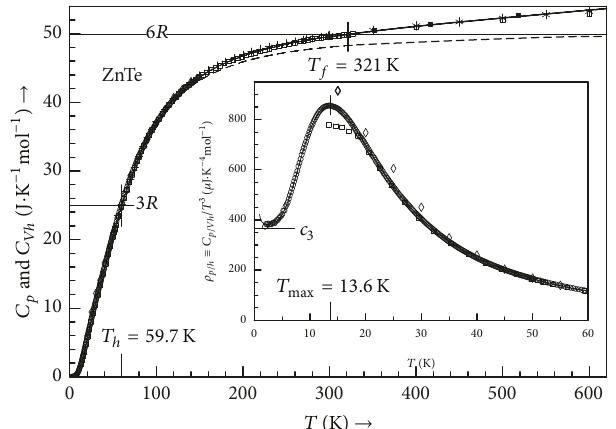
Figure 3: Fitting of the set of 𝐶 low 𝑝 (𝑇) data ( I ) provided for ZnTe by Kremer et al. [46] in combination with the upper section (102 K < 𝑇 < 327K)ofthe 𝐶 low (𝑇) datasetgivenbyGavrichevetal.[38]( ◻ ), 𝑝 a set of approximate 𝐶 high 𝑝 (𝑇) data points due to Gadzhiev et al. [80] ( ◼ ) (which we have redigitalized from their Figure 1 ), and a series of equidistant (smoothed) 𝐶 high 𝑝 (𝑇) data points ( ∗ ) available from the SGTEdatareview[81].Forcomparisonswithotherdataavailablefor ZnTe we have also visualized the low-temperature data points given by Demidenko and Maltsev [31] (+) and Irwin and Lacombe [33] ( ◊ ), including the smoothed high-temperature data points quoted by Gavrichev et al. [82] ( ◻ ) [ 𝐶 𝑝 (𝑇) curve (—; see (5)) and 𝐶 𝑉ℎ (𝑇) curve (–– –––; see (4), in combination with (9) and (14) to